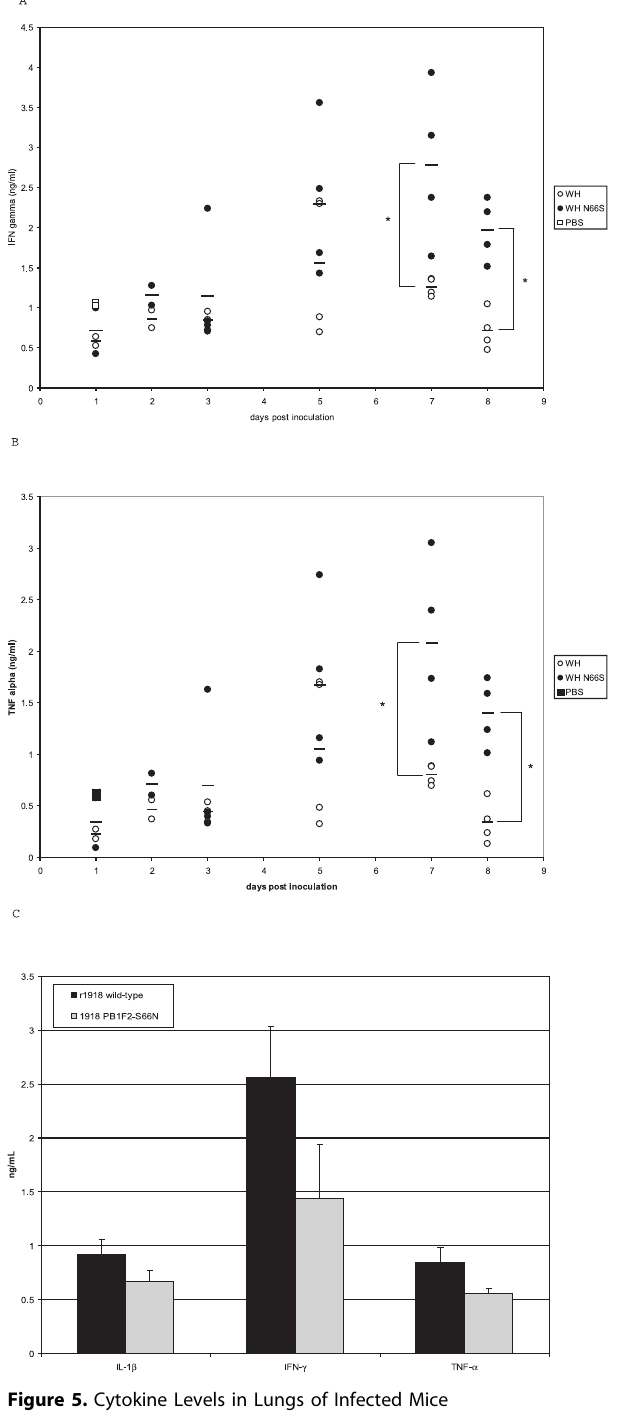
Figure 5. Cytokine Levels in Lungs of Infected Mice (A) IFN- c enzyme-linked immunosorbent assay was performed on lung homogenates with four mice per time point for each virus and is represented here in ng/ml. * p , .05. (B) TNF- a enzyme-linked immunosorbent assay was performed on lung homogenates with four mice per time point for each virus represented here in ng/ml. * p , .05. (C) Lung homogenates collected on day 4 after inoculation were measured for the levels of IL-1 b , IFN- c , and TNF- a using the Bioplex Protein Array system. All error bars represent 1 standard deviation.